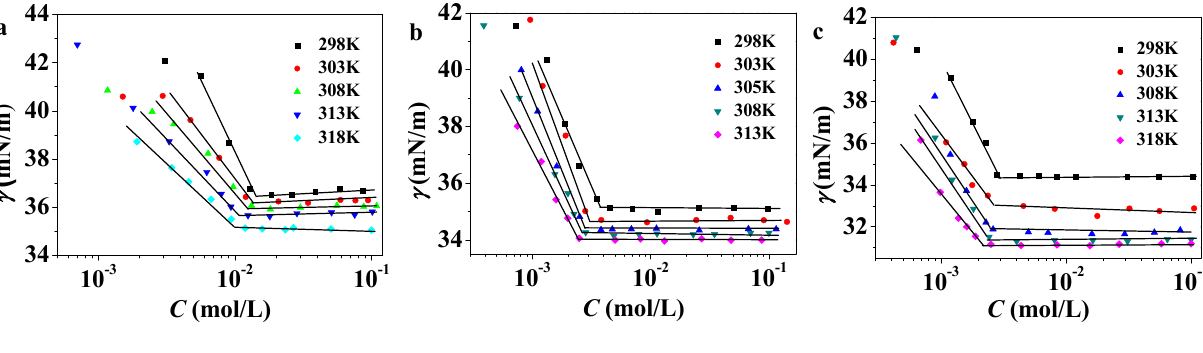
2. Critical micelle concentration ( cmc ) and thermodynamic parameters of micellization for C n PDB ( n =12, 14, 16) in EAN at various